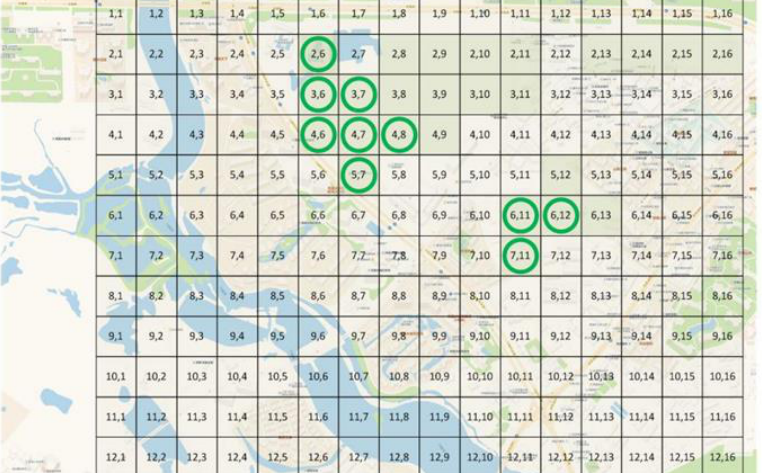
Figure 11. Final optimization scheme.